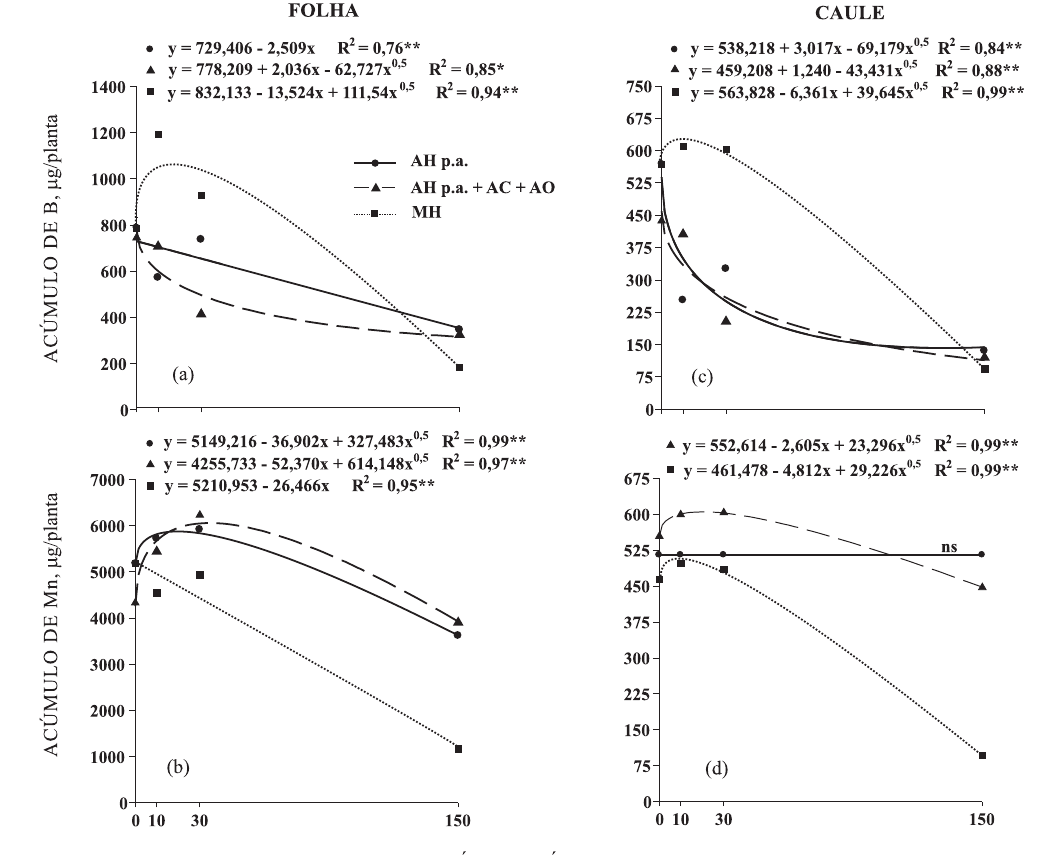
Figura 8. Acúmulo de B e Mn na matéria seca das folhas (a, b) e do caule (c, d) de mudas de eucalipto em resposta ao aumento de concentrações de C-ácido húmico em solução nutritiva. AH p.a.: ácido